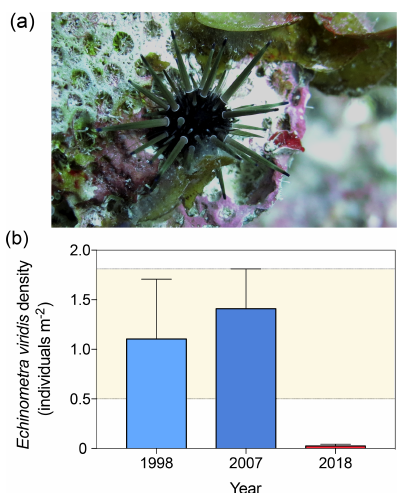
Figure 5. (a) Individual of Echinometra viridis among Orbicella annularis ramets at Long Caye in 2018 maintaining a cropped algae-free territory. (b) The density of E. viridis in the 1998, 2007, and 2018 surveys (the error band represents the maximum upper and lower standard deviation of the 1998 and 2008